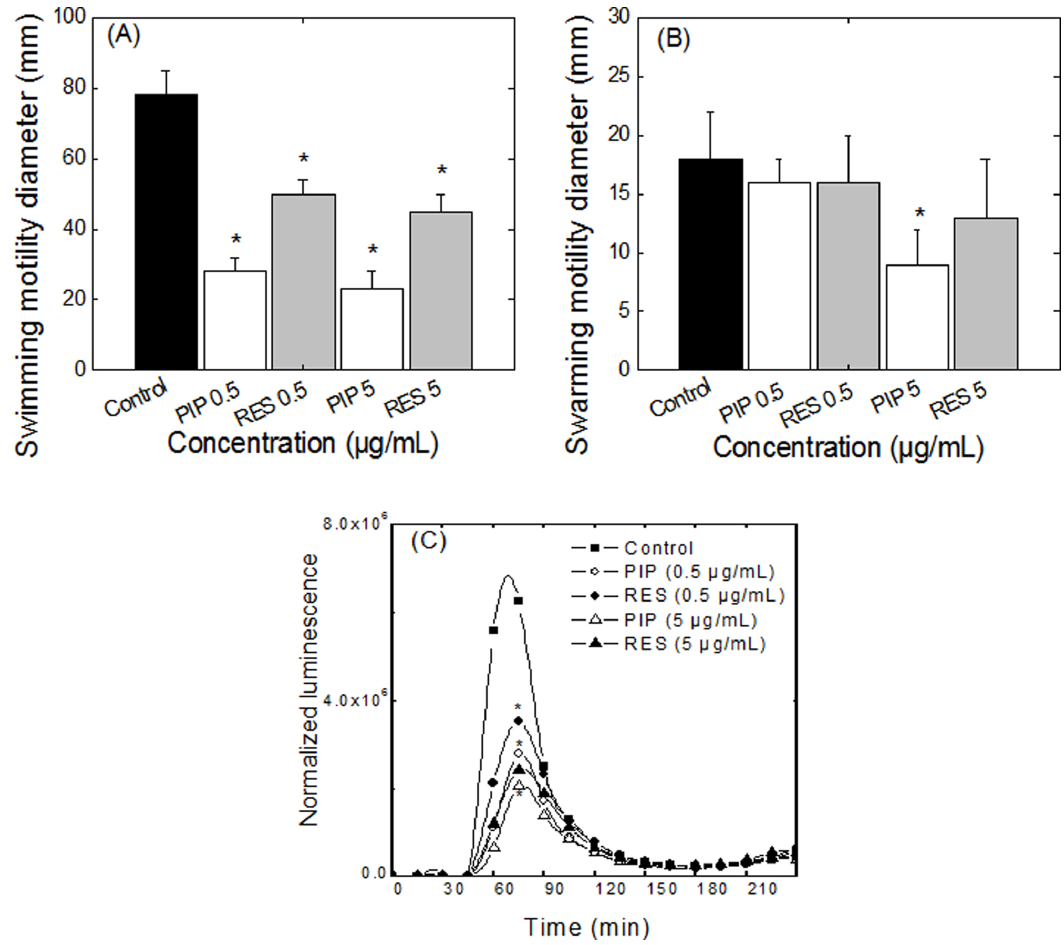
Figure 4. Effects of PIP and RES on E.coli CFT073 motility and flagellin expression. (A) swimming and (B) swarming motility of E. coli CFT073, (C) expression of flagellin in E. coli P fli C-lux in presence and absence of PIP and RES. * indicates statistically significant difference in values ( p , 0.05) with respect to the control.